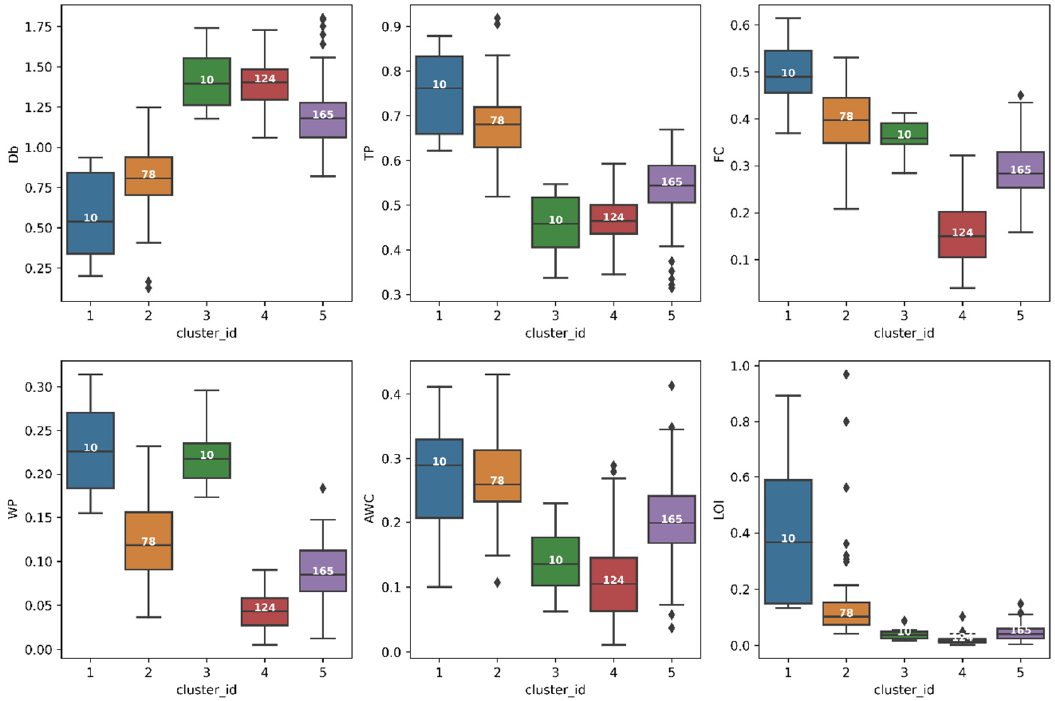
Figure 5. Physical and hydraulic properties in the five identified clusters. The bar plots show median + IQR (whiskers represent 1st/99th percentiles and dots outliers). The cluster sizes (total N = 387) are shown in white.